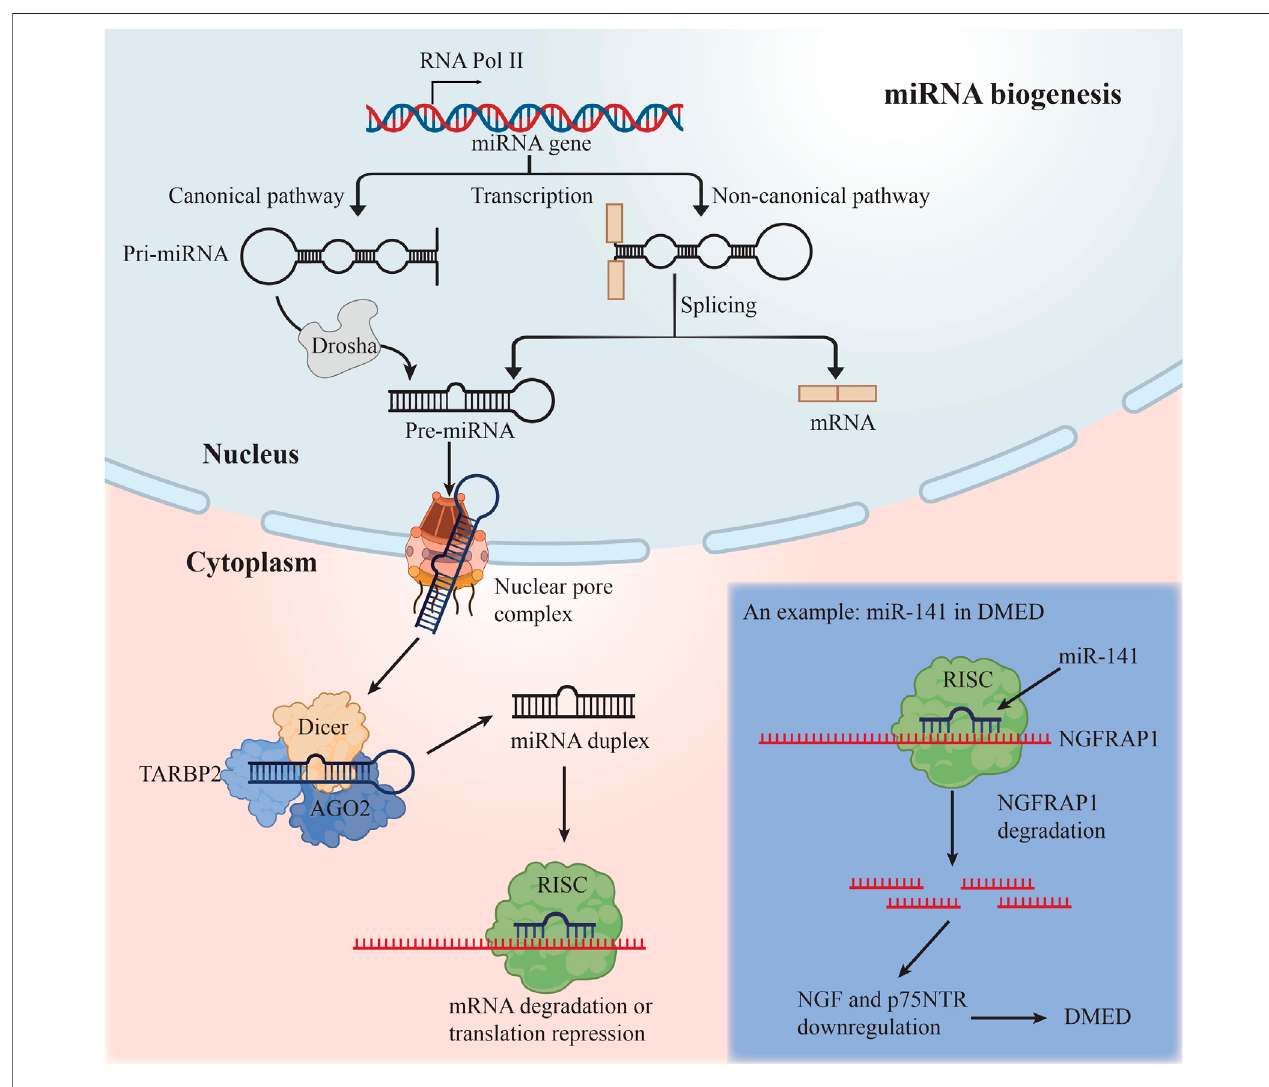
FIGURE 2 | The biogenesis of miRNAs and an example of miRNA in